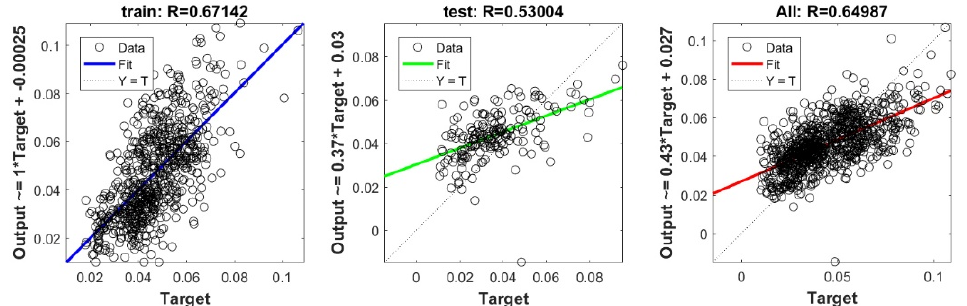
Figure A23. Scatter plots between target and output value by the PSO-GP model.